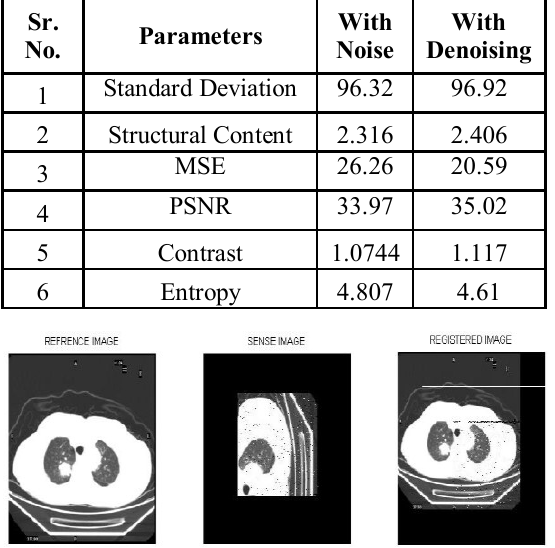
Fig 4. Image Registration for Abdomen CT with Noise effect